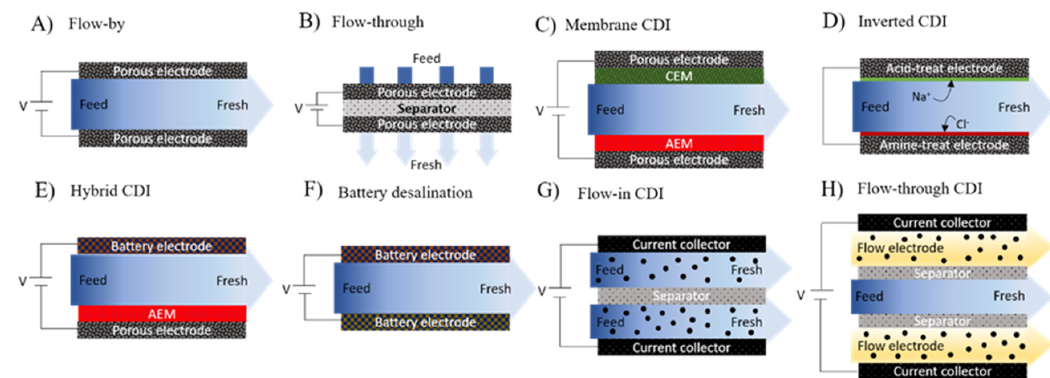
Figure 4. Cell composition of CDI family cells.